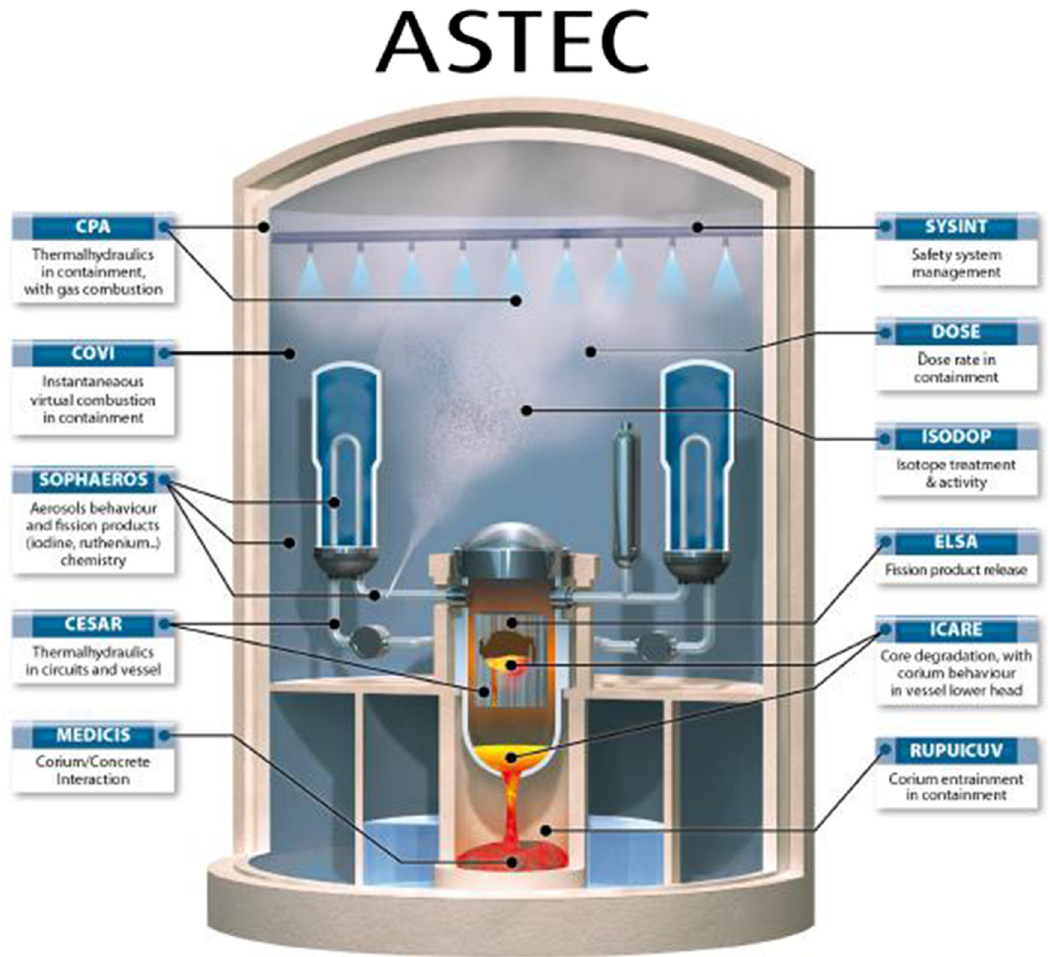
Fig. 3. ASTEC integral code for simulation of severe